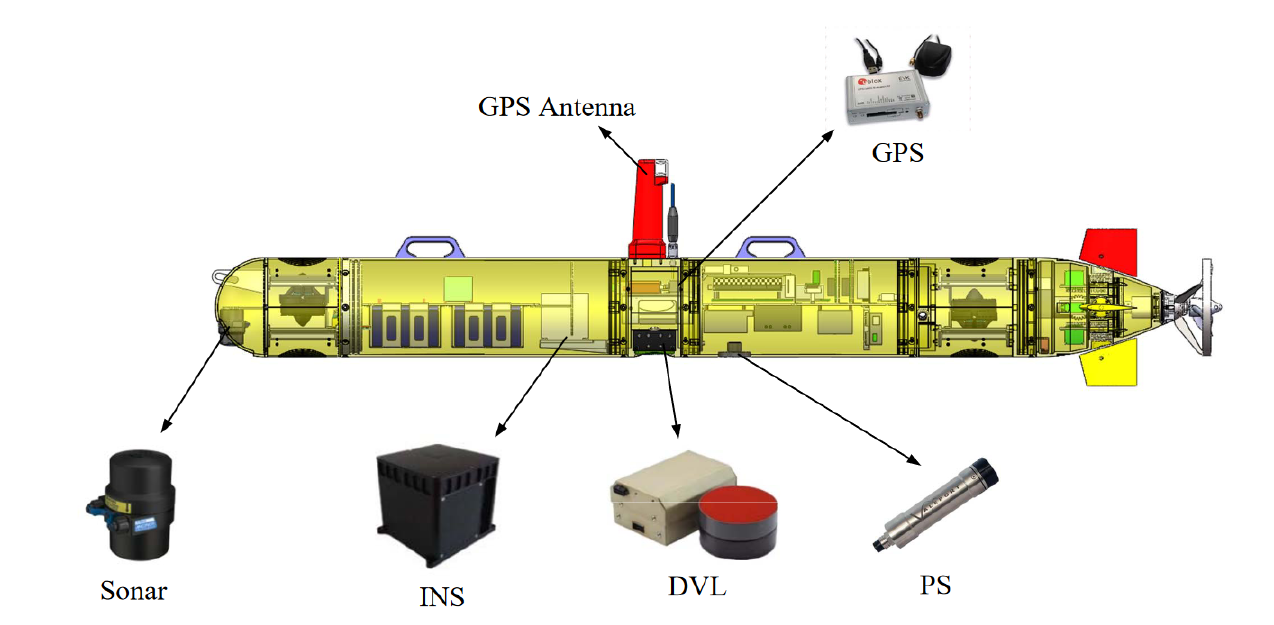
Figure 1. The Sailfish-210